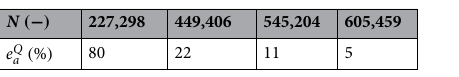
Table 3. Relative discretization errors from grid sensitivity